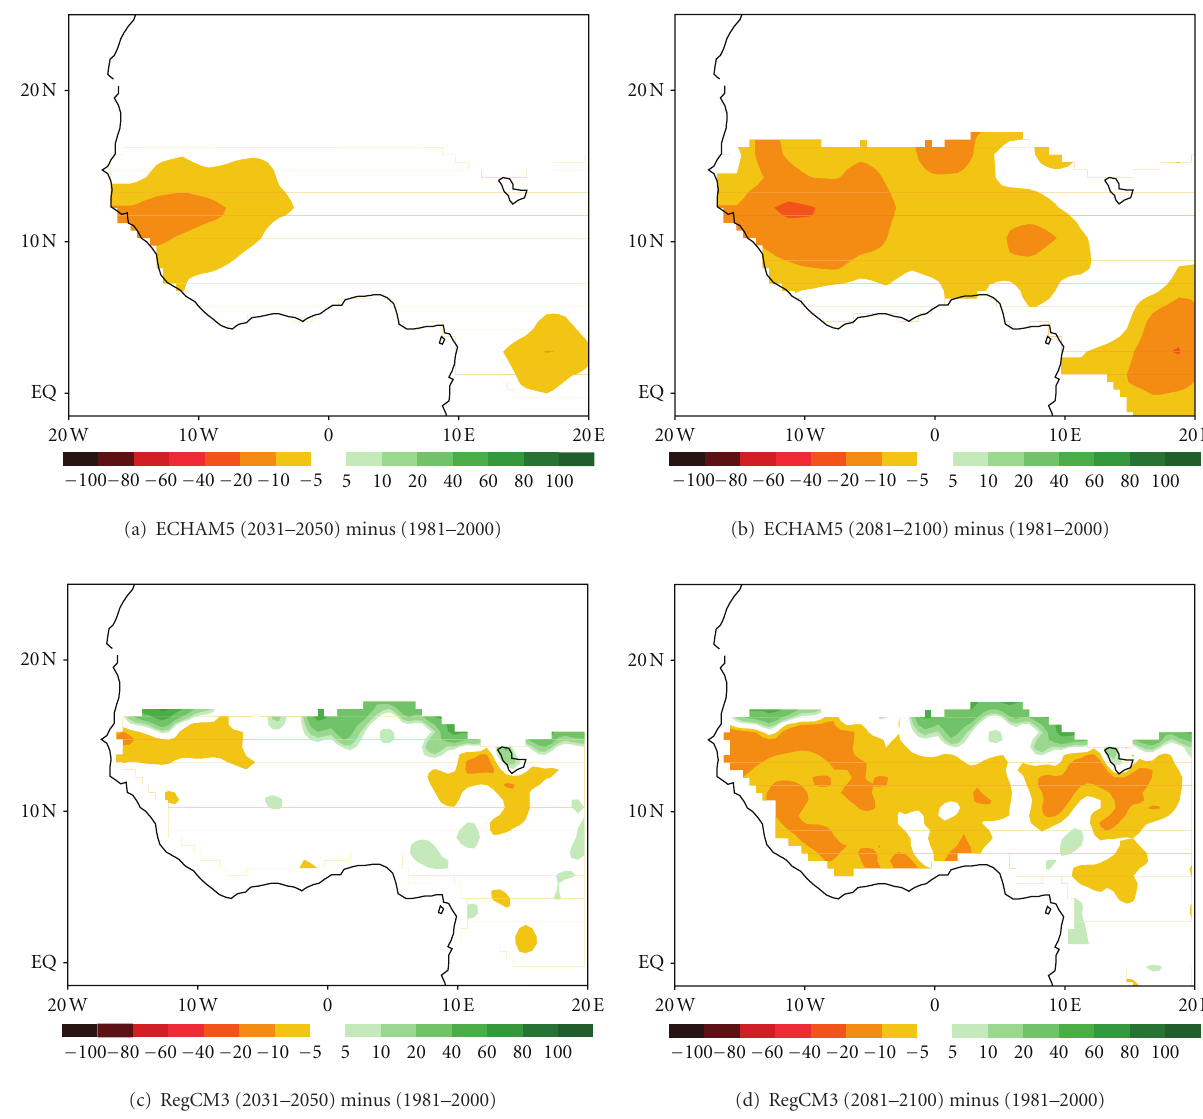
Figure 4: The same as Figure 3 but for total soil moisture